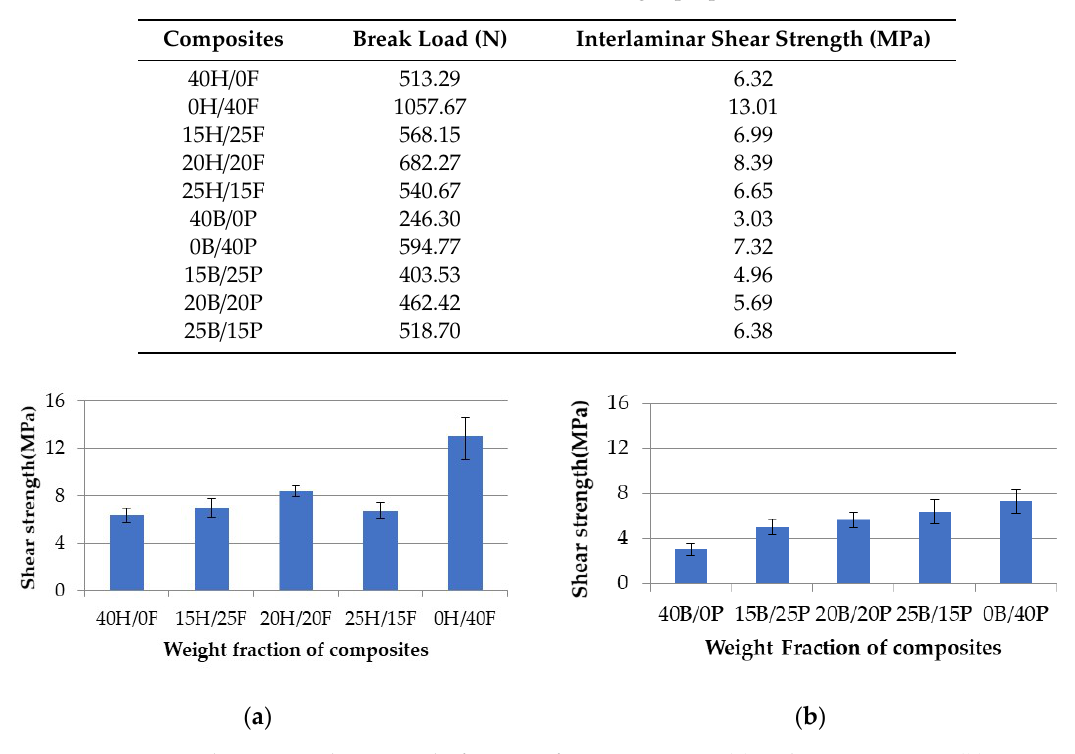
Figure 9. Shear strength vs. weight fraction of H/F composites ( a ) and B/P composites ( b ).